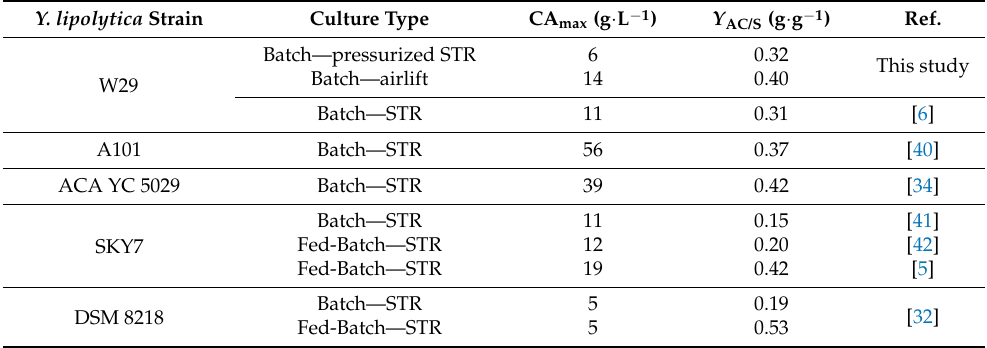
Table 3. Maximum citric acid production (CA max , g · L − 1 ) and global conversion yield of citric acid produced per crude glycerol consumed ( Y AC/S , g · g − 1 ), obtained in several wild-type Y. lipolytica strain cultures carried out in lab-scale bioreactors. Comparisons with the current